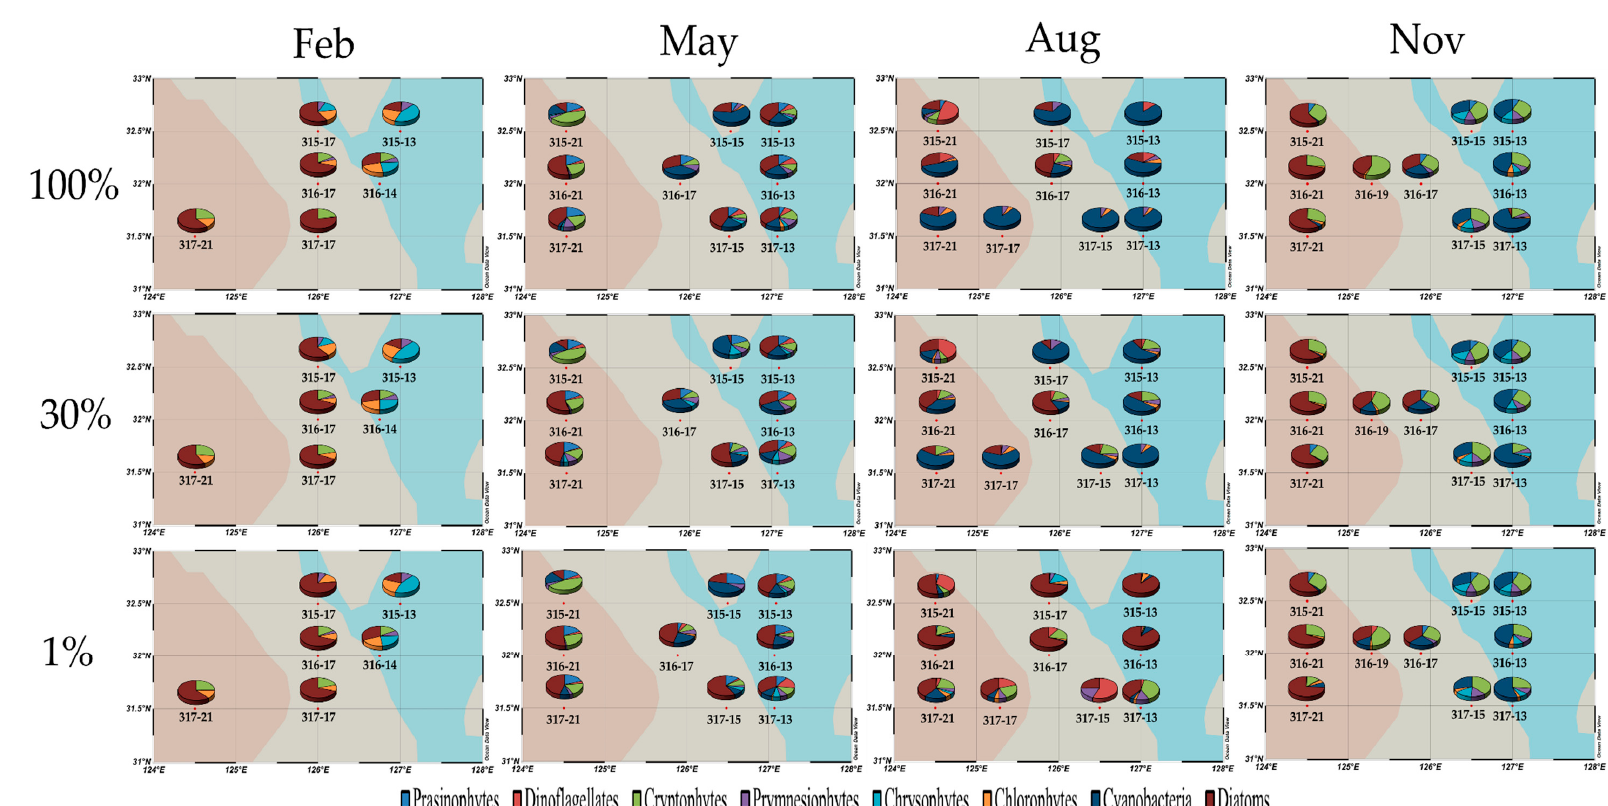
Figure 4. Seasonal distributions of phytoplankton communities at the euphotic depths (100%, 30%, and 1%) in the northern East China Sea, 2018.